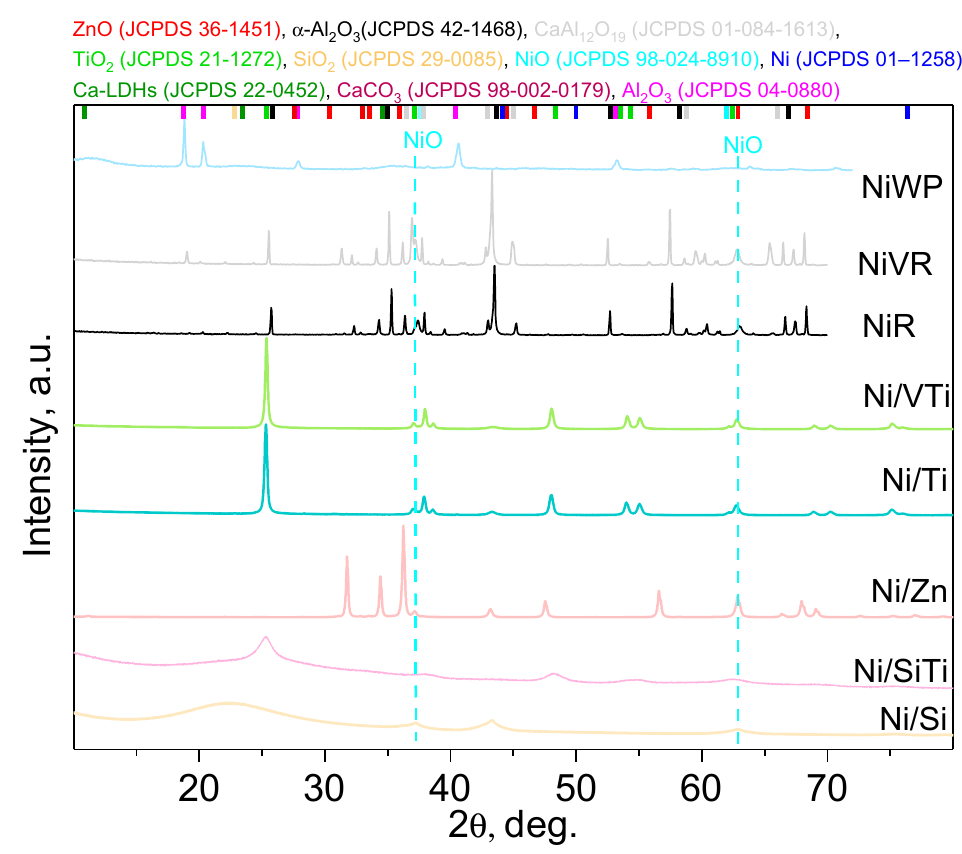
Figure 1. XRD patterns of the calcined samples.